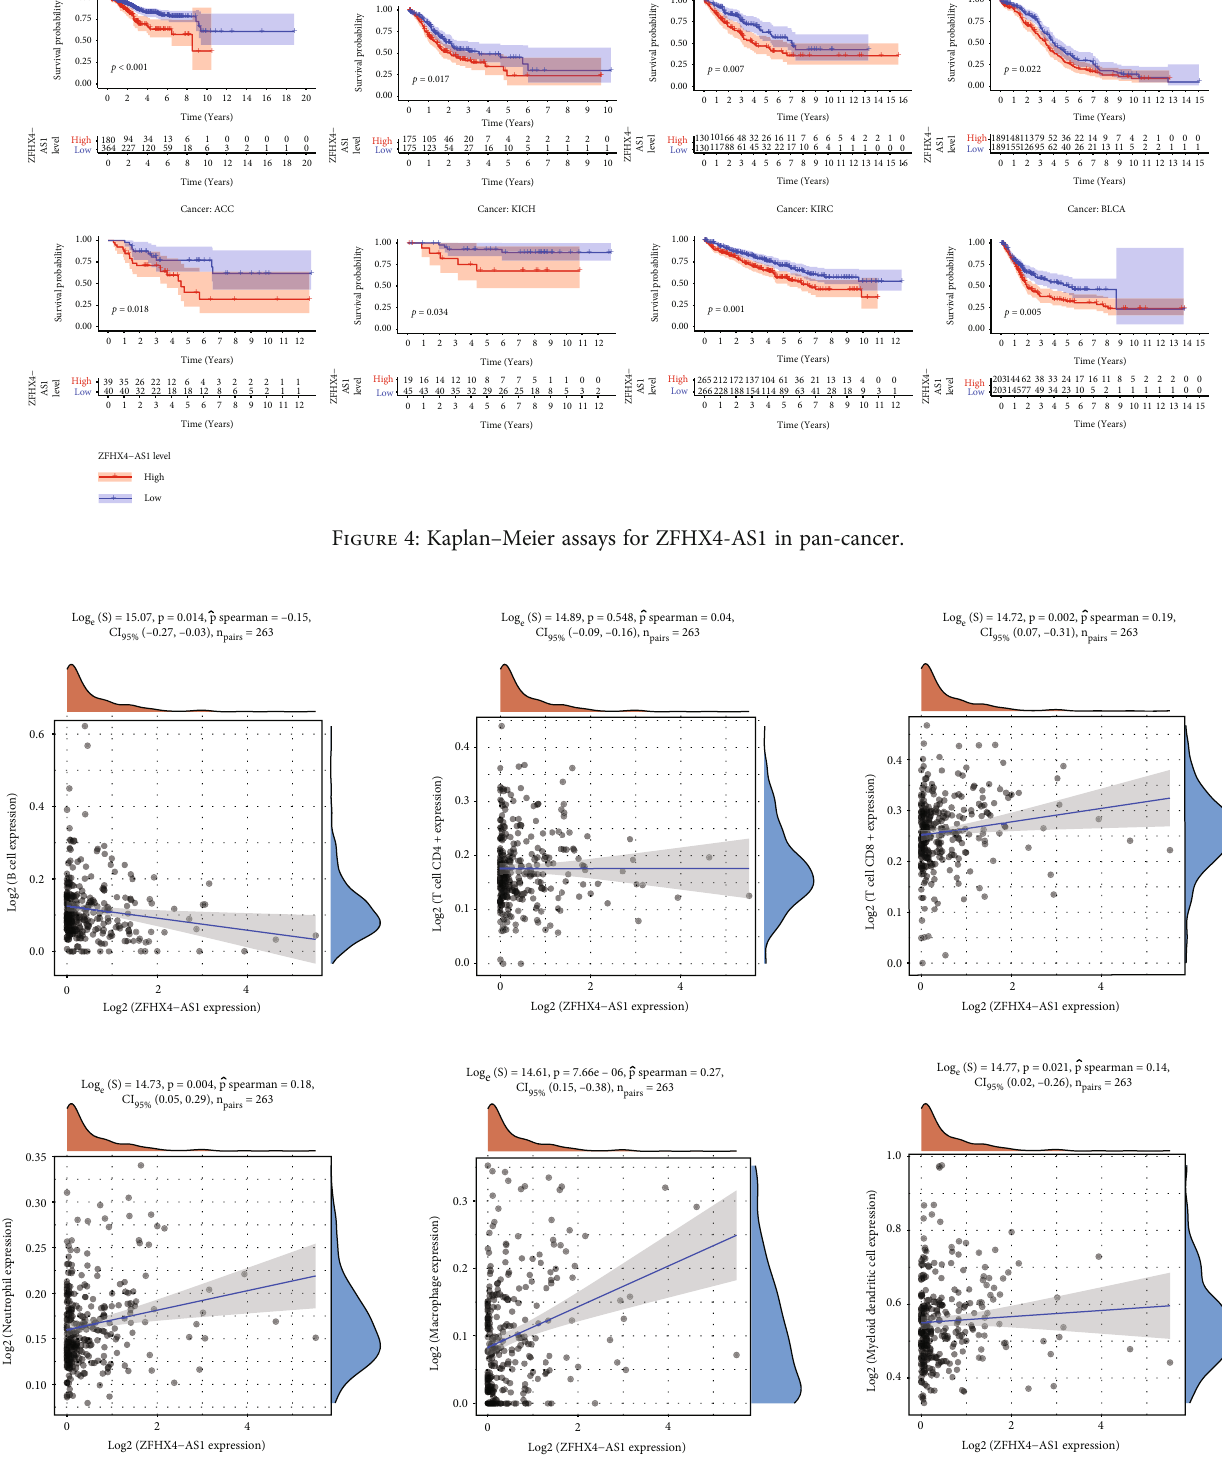
Figure 5: Correlations of ZFHX4-AS1 expressions with the levels of immune in fi ltration in